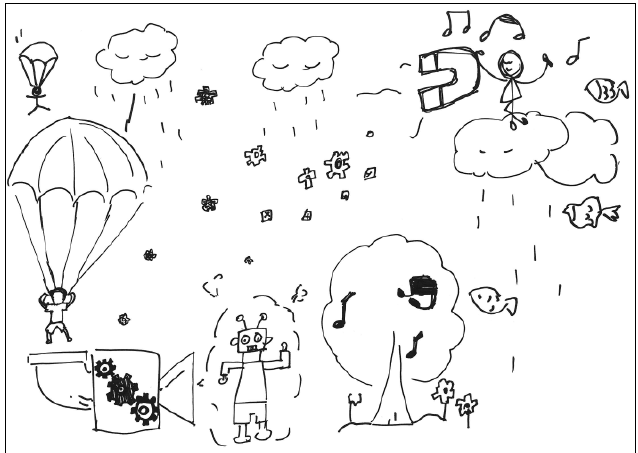
Figure 11. Work by AD Averaging Depression.